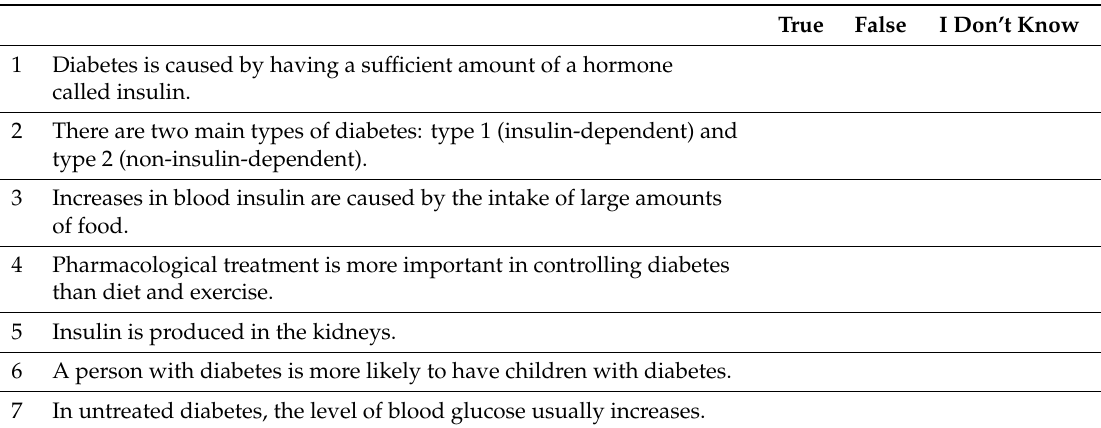
Table A1. Level of Knowledge of